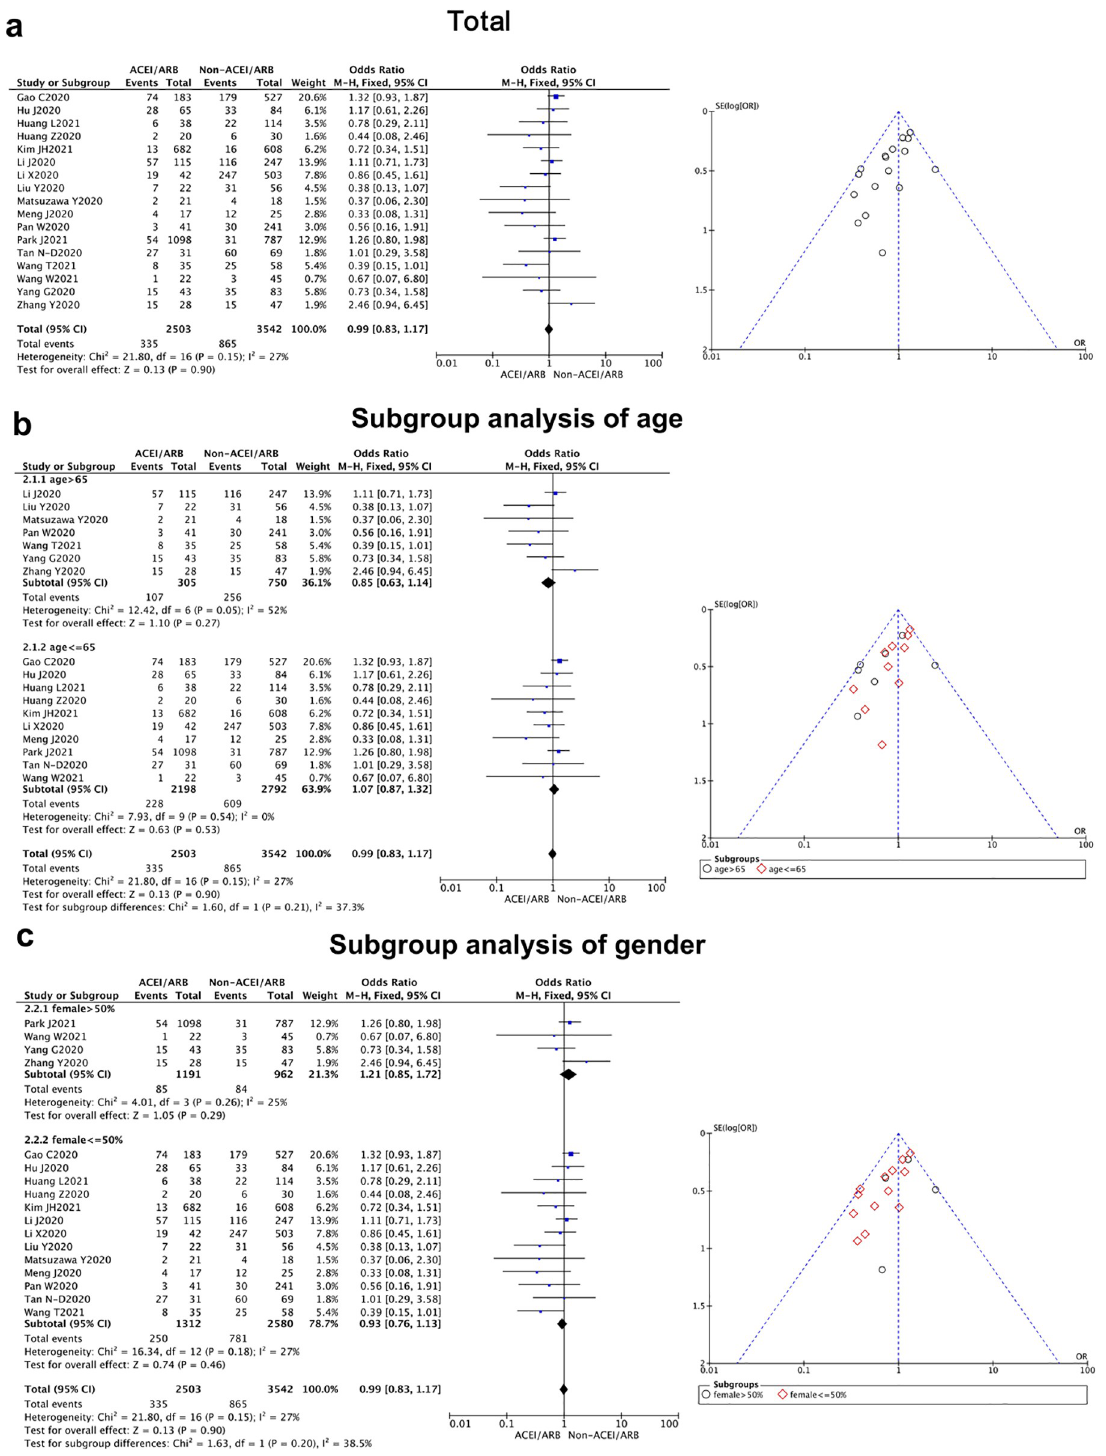
Fig 3. Severity of East-Asian Covid-19 patients treated with ACEI/ARB vs. untreated subjects. The severity data of OR and 95% CI from 17 studies were pooled in this meta-analysis and the result of meta-analysis was described as a forest plot. (a) The whole group analysis; (b) The subgroup analysis of age; (c) The subgroup analysis of gender.